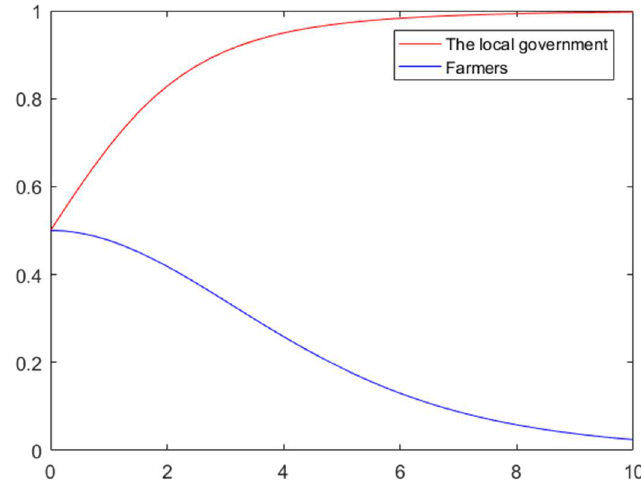
Figure 8. Simulation results at the third stage ( ∆ S 2 = 1.5, ∆ S 1 = 2.5).